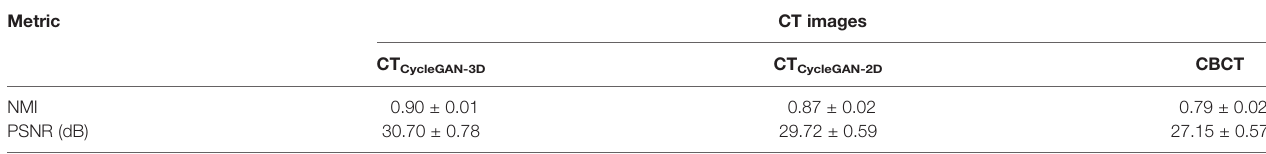
TABLE 3 | Metric results between real CT images and different CT images of 20 patients with cervical cancer.